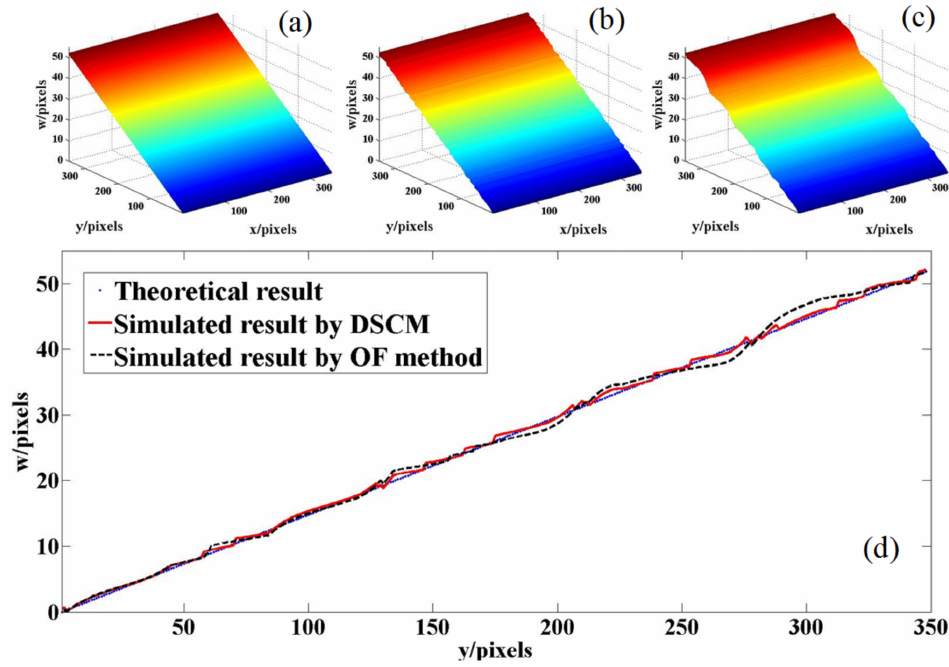
Figure 3. Simulation experiment results: ( a ) theoretical result; ( b ) simulated result by DSCM; ( c ) simulate result by OF method ( d ) comparison cross-section data in the y direction at x =